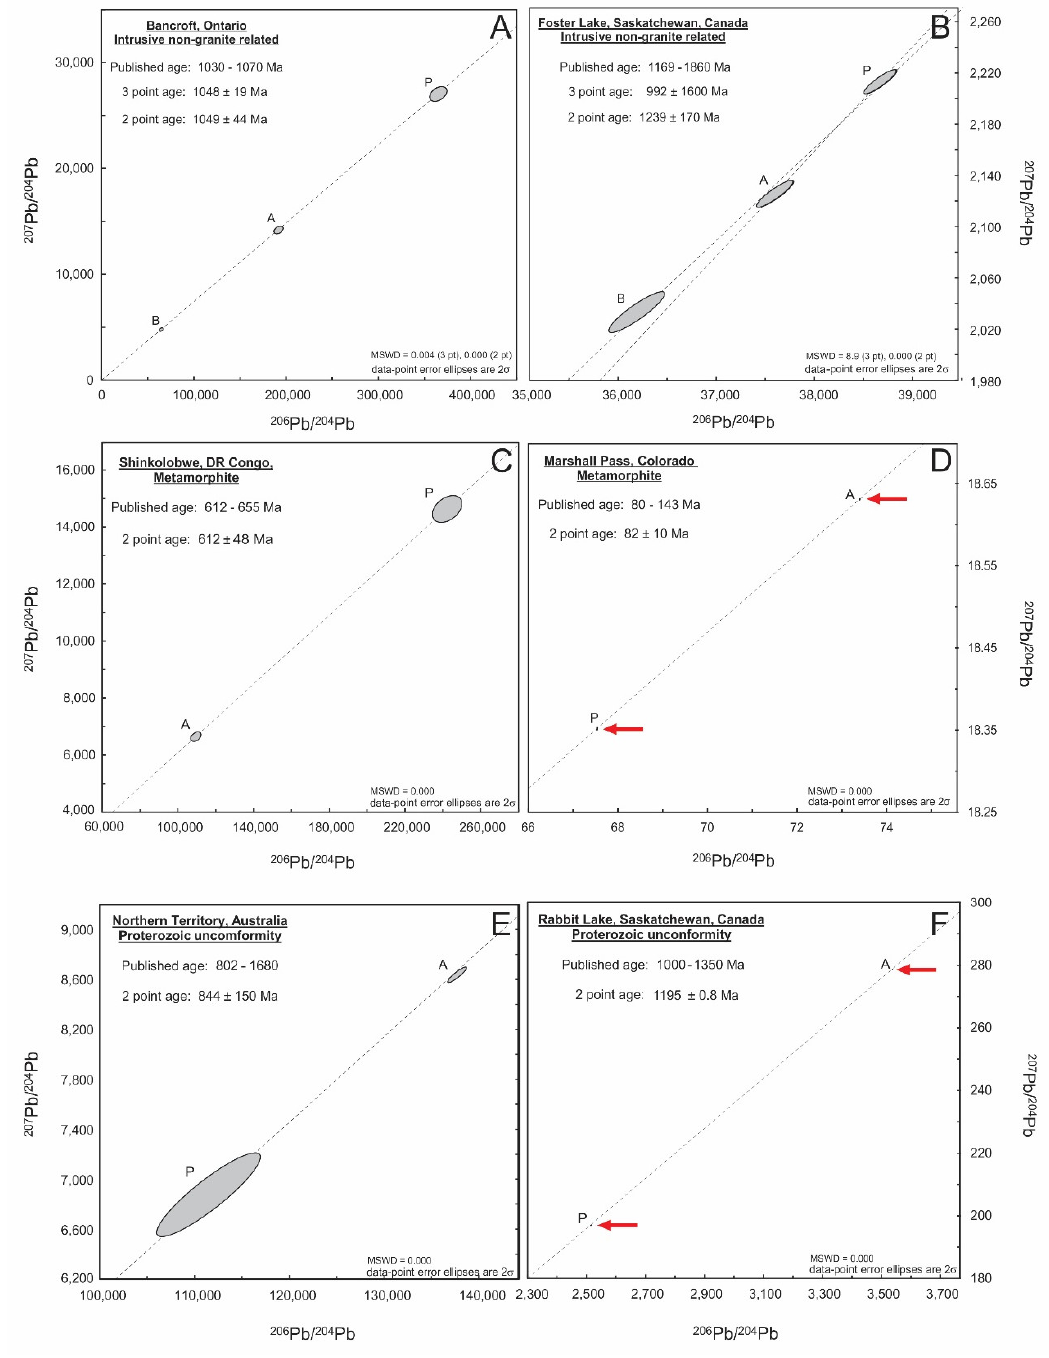
Figure 5. Secondary Pb–Pb isochron for the remaining 2 intrusive non-granite related samples, ( A ) Bancroft, and ( B ) Foster Lake, two metamorphite deposit related samples, ( C ) Shinkolobwe, and ( D ) Marshall Pass, and the Proterozoic unconformity related samples, ( E ) Northern Territory, Australia, and ( F ) Rabbit Lake. Symbol size (including associated uncertainty) for certain analyses are difficult to see, due to large range (scaling) of Pb isotope compositions. Therefore, a red arrow is shown to indicate the position of these analyses.